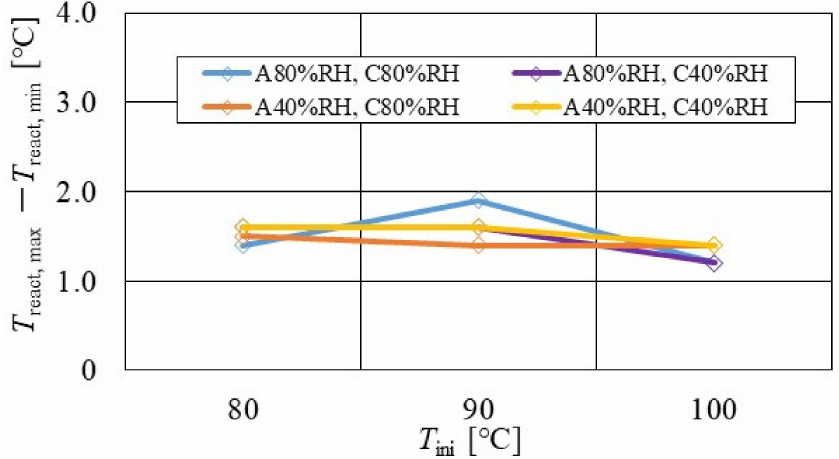
Figure 13. Effect of relative humidity and initial operation temperature and temperature difference, between the maximum and the minimum temperature in the distribution of temperature at reaction surface, for the separator thickness of 2.0